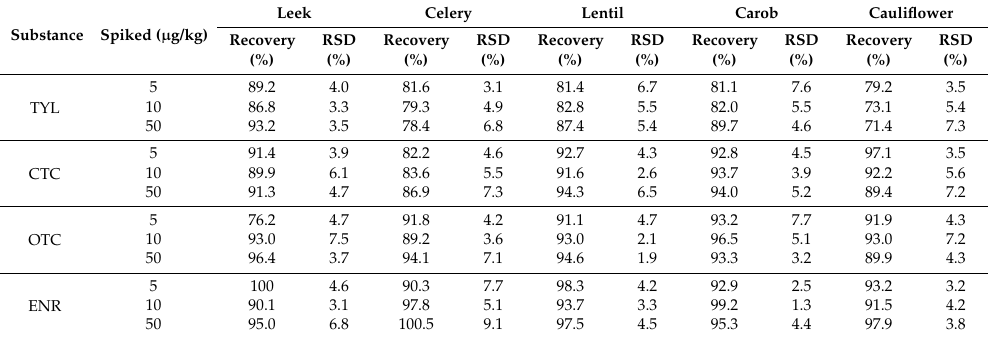
Table 3. Recovery of eleven antibiotics in vegetables ( n =